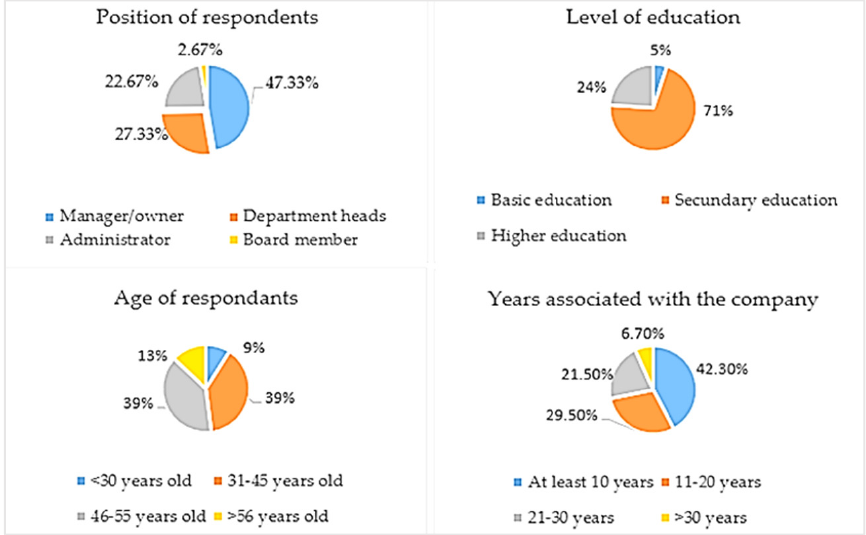
Figure 2. Characteristics of the informants.